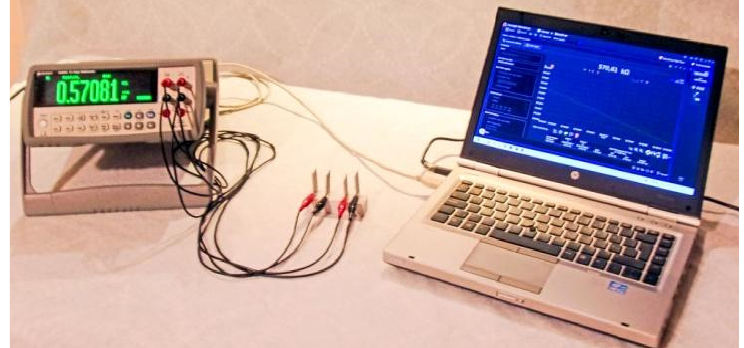
Figure 7. Four-wire method set-up.